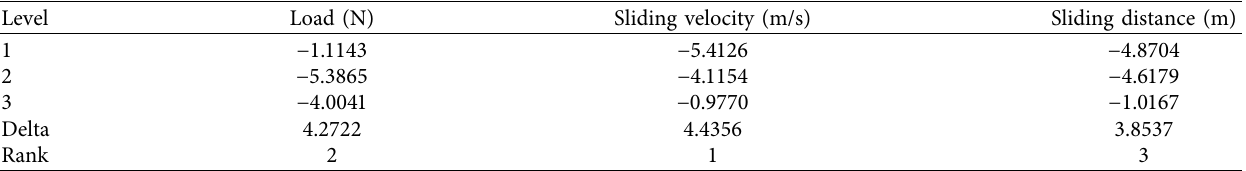
Table 4: Signal-to-noise ratio value of